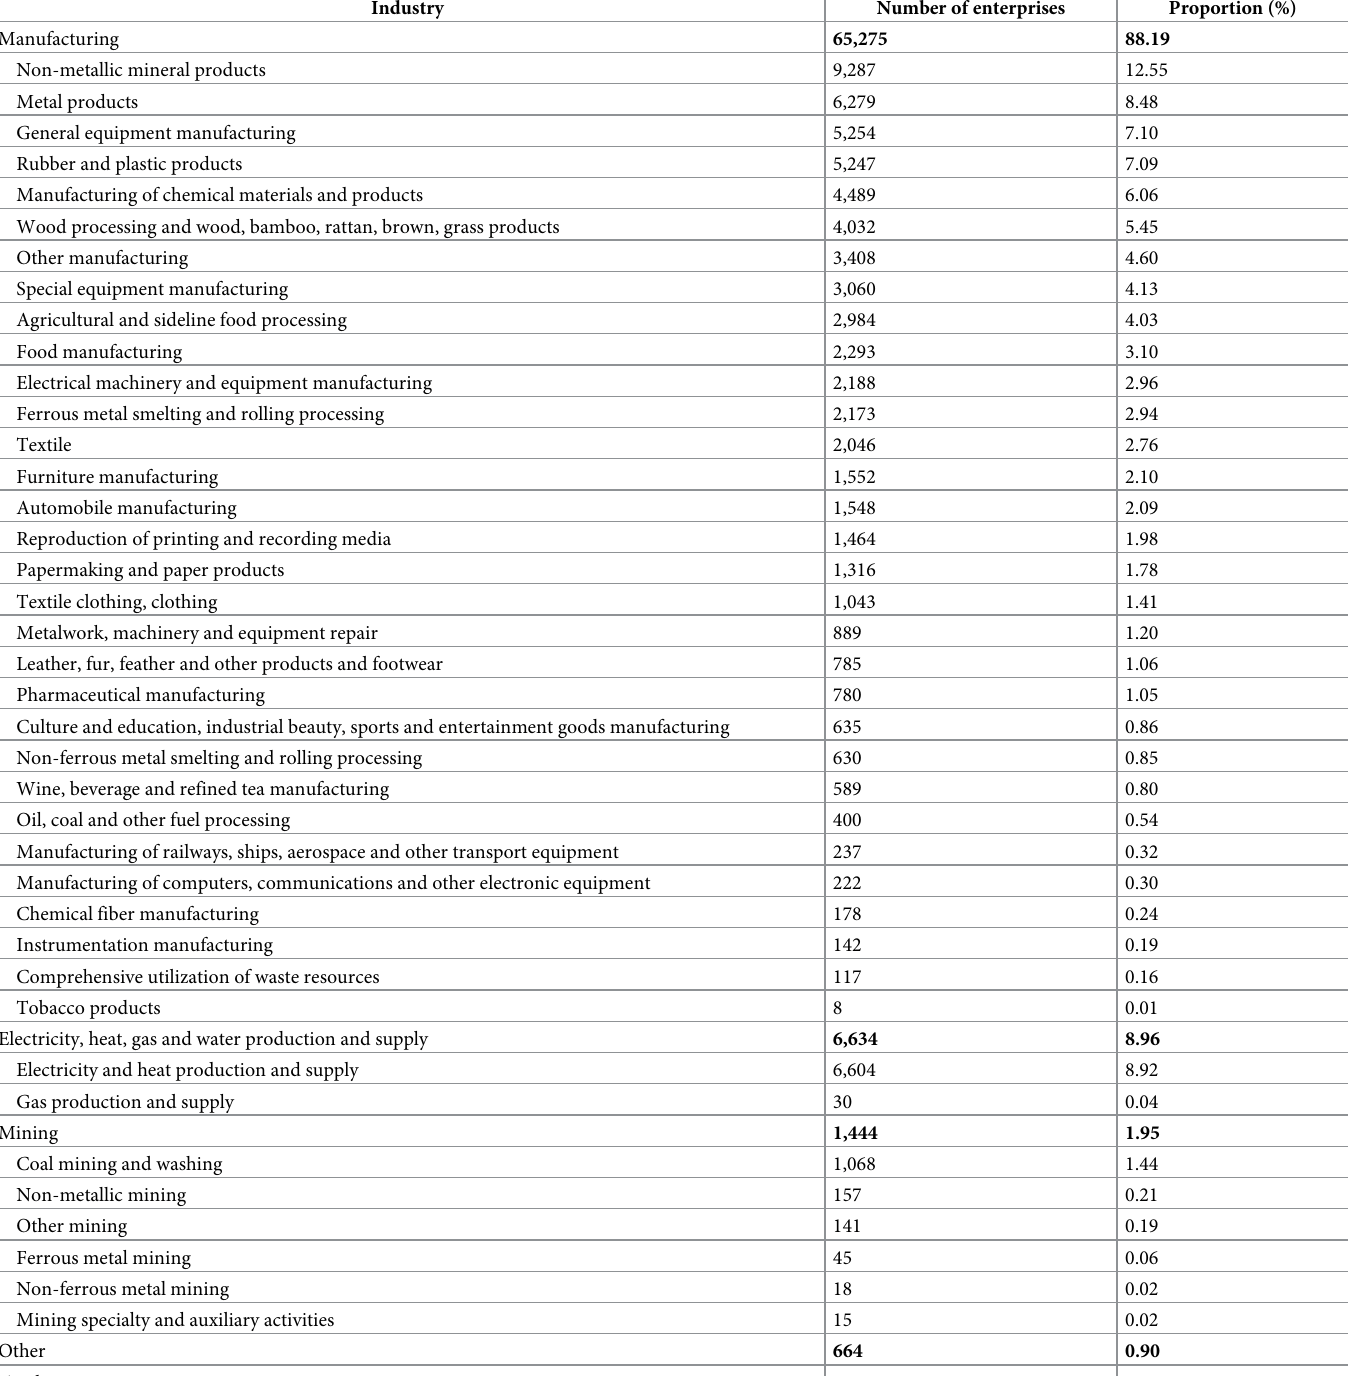
Table 4. Distribution of industrial enterprises in the BTH “2+26”